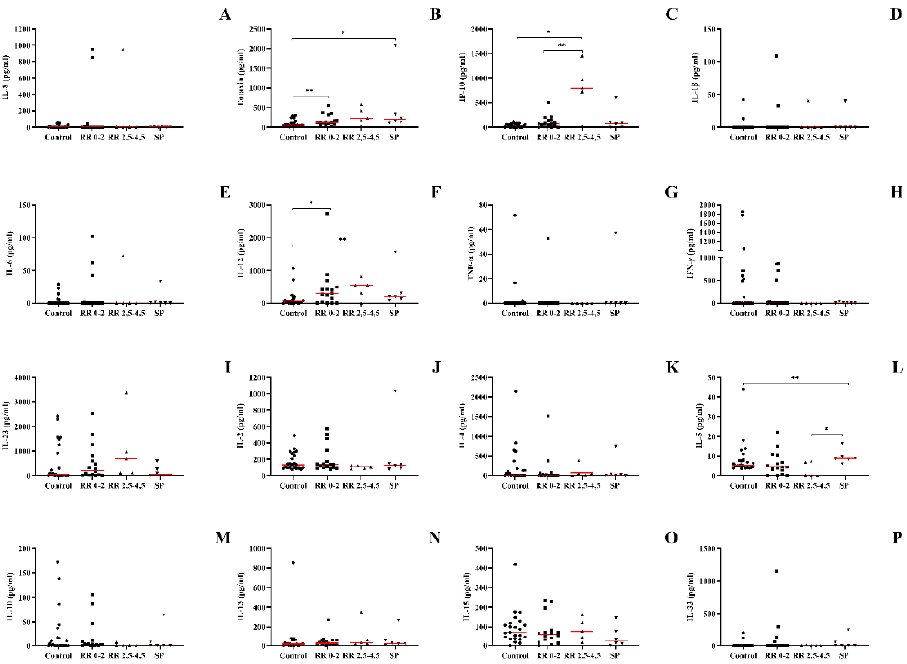
Figure 3. Concentration of cytokines and chemokines in the plasma of patients with multiple sclerosis according to clinical form and EDSS score compared to healthy individuals obtained by enzyme- linked immunosorbent assay. ( A ) IL-8, ( B ) CCL-11/eotaxin-1, ( C ) CXCL-10/IP-10, ( D ) IL-1 β , ( E ) IL-6, ( F ) IL-12, ( G ) TNF- α , ( H ) IFN- γ , ( I ) IL-23, ( J ) IL-2, ( K ) IL-4, ( L ) IL-5, ( M ) IL-10, ( N ) IL-13, ( O ) IL-15, and ( P ) IL-33. Healthy control, RR (relapse–remitting multiple sclerosis) subdivided: EDSS 0–2 and EDSS 2.5–4.5; SP (secondary progressive multiple sclerosis). Rows represent the median. Statistical analysis was performed using the Kruskal–Wallis test with Dunn’s post-test, where * and ** represent p < 0.05.